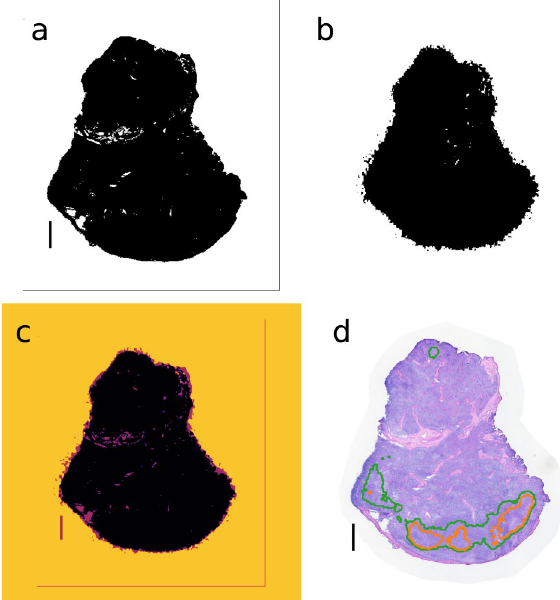
Figure 6. Registration procedure between iQID dose-rate images and H&E-stained images. ( a ) H&E thresholded binary image. ( b ) iQID dose-rate-map thresholded binary image. ( c ) Co-registration of ( a ) and ( b ) using scale factors and 2D transformations. ( d ) Contours of high-activity regions from Fig. 4b overlaid on H&E image. Scale bars show 1